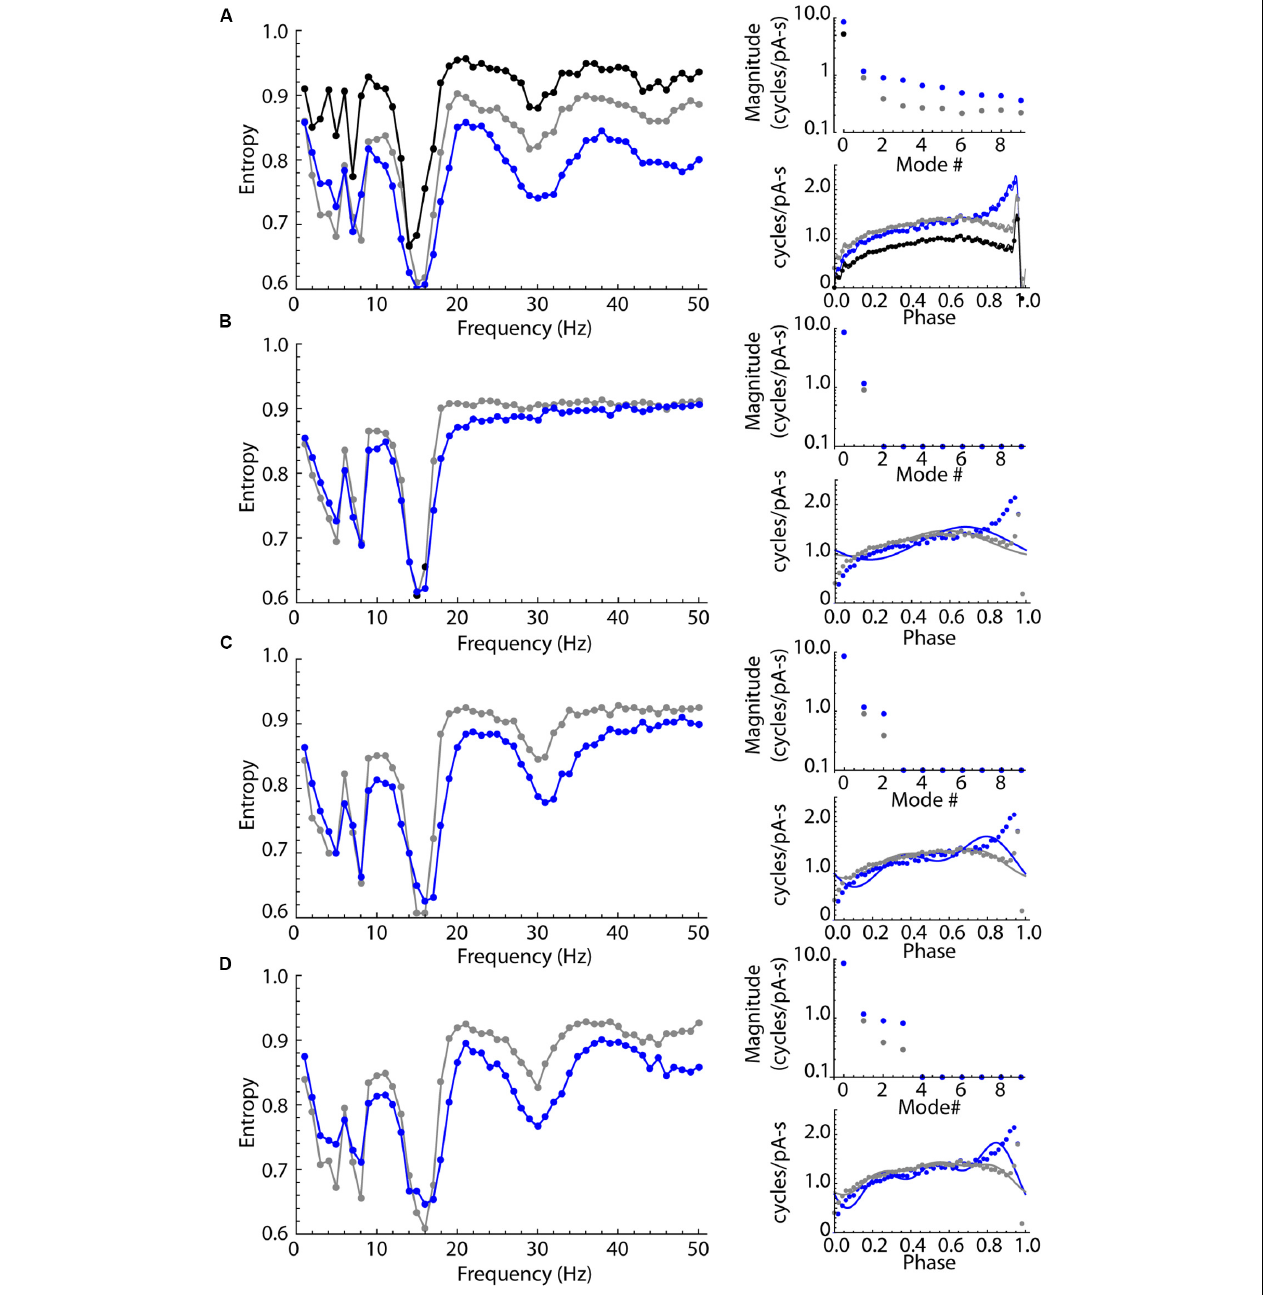
FIGURE 8 | Sinusoidal entrainment in phase models of the LTS interneuron (in blue) and the SP neuron (in black and gray). (A) Entrainment spectra from 1 to 50 Hz for the phase model LTS interneuron (blue) and the SP neuron (black) using a phase model with all modes present. To test for the influence of the DC component mode 0, the SP neuron PRC was shifted to have the same mode 0 as the LTS interneuron, and the spectrum for that version of the SP neuron model is shown in gray. This mode 0 equalization brought the entrainment spectra mostly into alignment for frequencies at and below the cells’ unperturbed rate (15 spikes/s). The entrainment at higher frequencies continued to be different, with the SP neuron showing consistently higher entropy (less entrainment). The amplitudes of the first 10 modes in both PRCs are shown at right, including the shift in mode zero between the measured value for SP neurons (black), LTS neurons (blue) and the mode 0-equalized SP neuron (gray). The PRCs used in these simulations are shown at lower right in (A) . (B) The effect of equalizing mode 0 as above, and removing all modes higher than mode 1, which corresponds to the cell’s firing rate. At right are shown the amplitudes of modes and the synthetic PRCs (lines) superimposed on the original PRCs (points). The only difference between PRCs is the difference in amplitude and phase of mode 1. The cell type difference in entrainment at high frequencies is absent, except for a small range of frequencies near the cells’ firing rate. (C) . The same comparison except including differences in modes 1 and 2. The secondary (1:2) entrainment at twice the cells’ frequencies is returned and the difference in entrainment in that frequency range is restored. (D) Restoring modes 1 through 3 reproduces most of the original differences in high-frequency entrainment between the cell types.